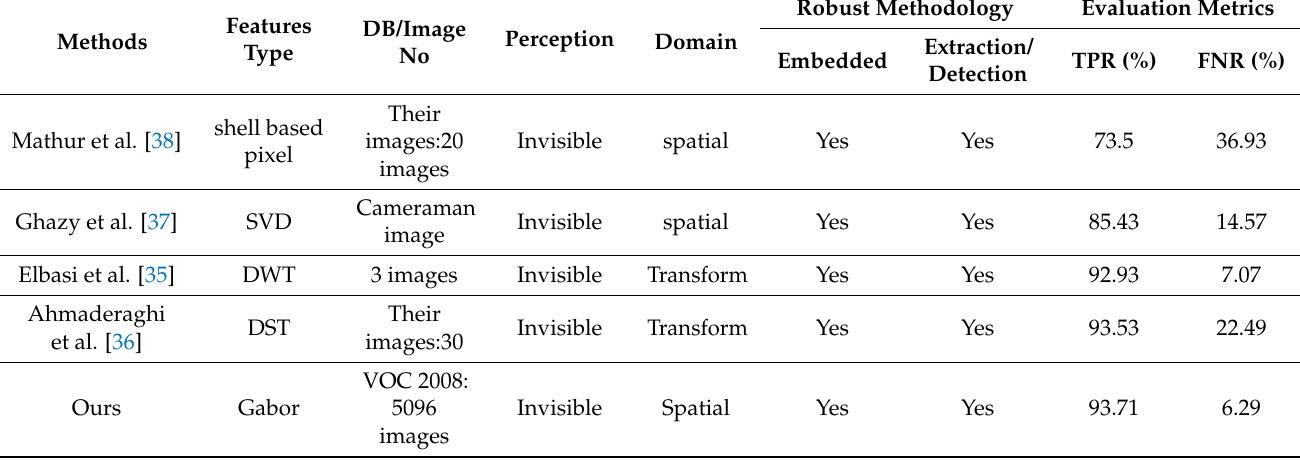
Table 2. Performance comparison with previous